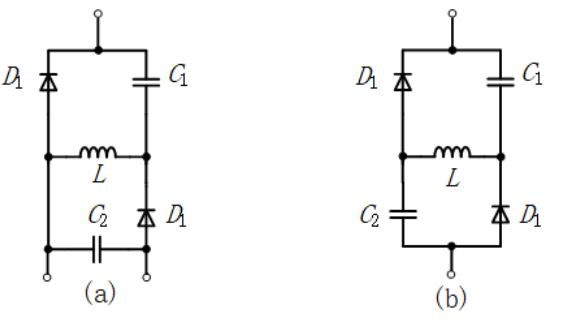
Figure 20. Basic voltage multipliers. ( a ) [40]. ( b ) A simple voltage multiplier.